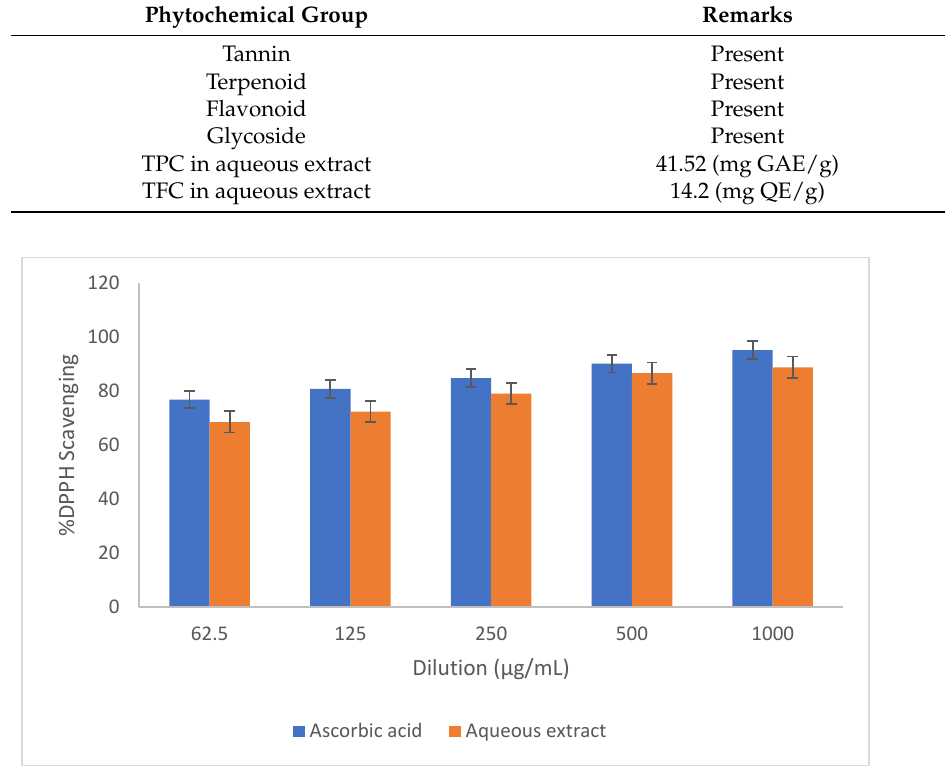
Figure 1. Free radical scavenging effects of aqueous extract of E. wallichii (IC 50 of ascorbic acid = 10 μ g/mL, IC 50 of aqueous extract = 32 μ g/mL).